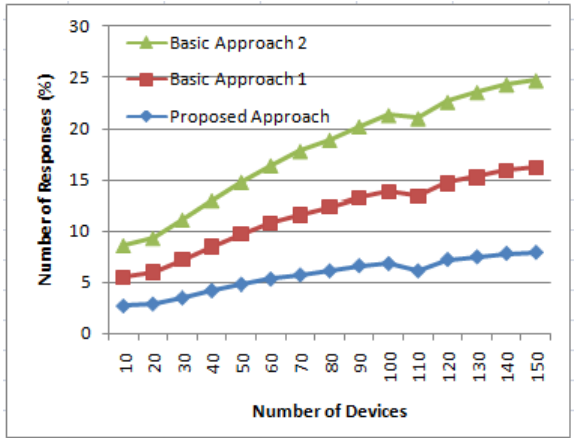
Figure 6. Number of